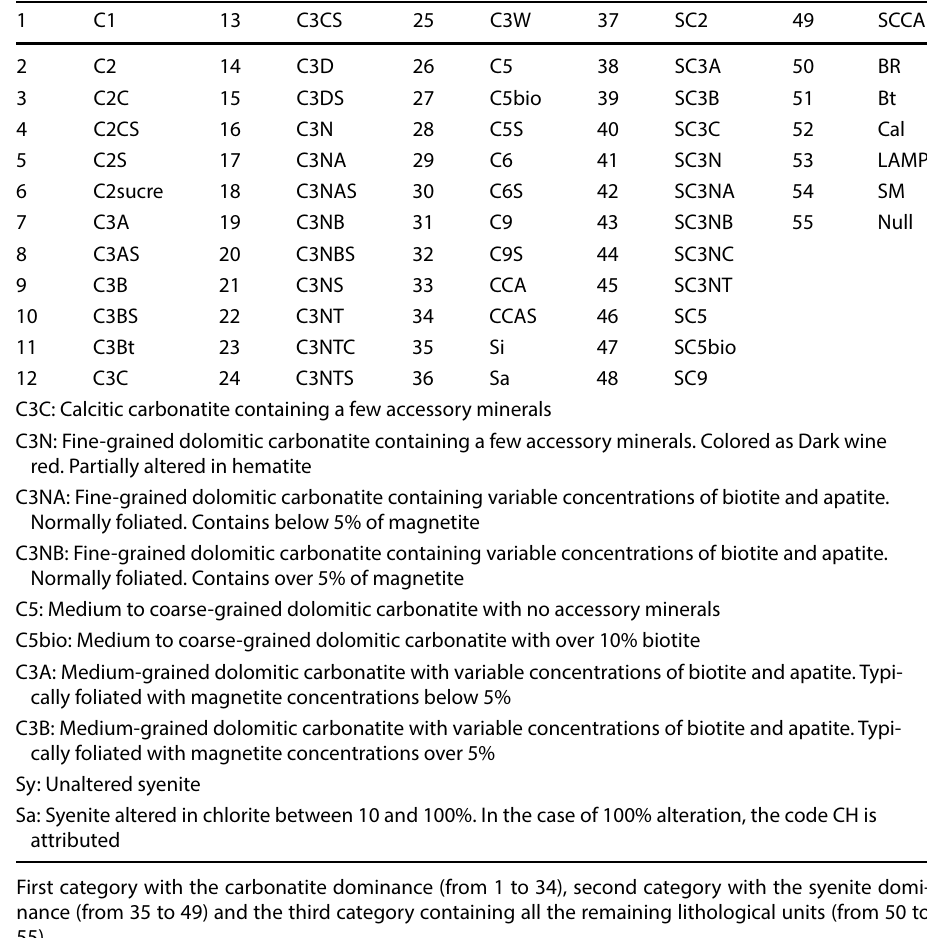
Table 2 The type and number of laboratory tests conducted by different campaigns at the Niobec Mine